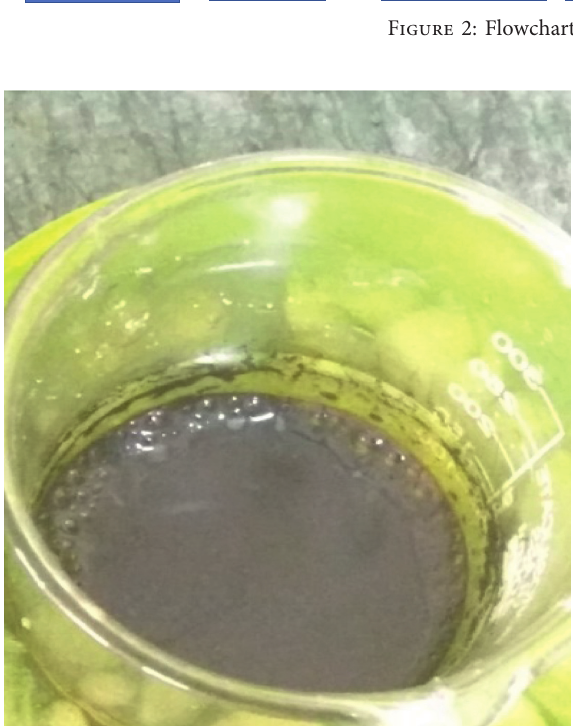
Figure 3: Mixture in ice bath below 2 ° C for about 1 hour.